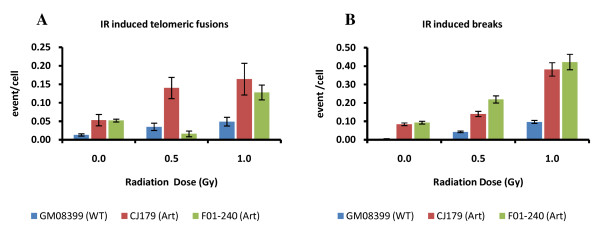
IR induced telomeric fusions in Artemis defective cells. A. Telomeric fusions. B. Chromosome breaks. Two doses of IR were used: 0.5 Gy and 1.0 Gy in three independent experiments. Over 100 metaphase cells were analysed per dose. The error bars represent SD.